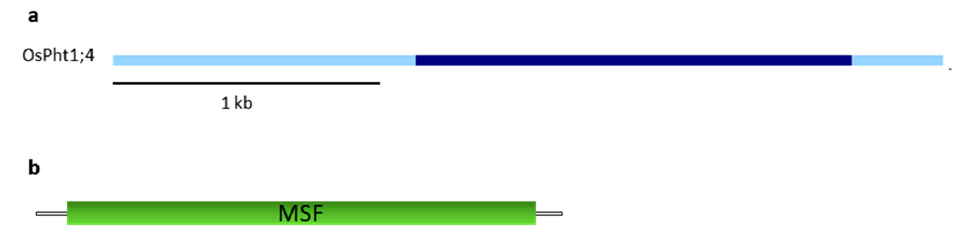
Figure 5. ( a ) Gene structure of OsPHT1;4. Light and dark blue rectangles represent UTRs and coding exons, respectively, the black bars correspond to introns. The gene structure was obtained as described in Figure 1a legend. ( b ) Predicted domain of the OsPHT1;4 protein by PFAM [98] software. The major facilitator superfamily (MFS) domain is represented.